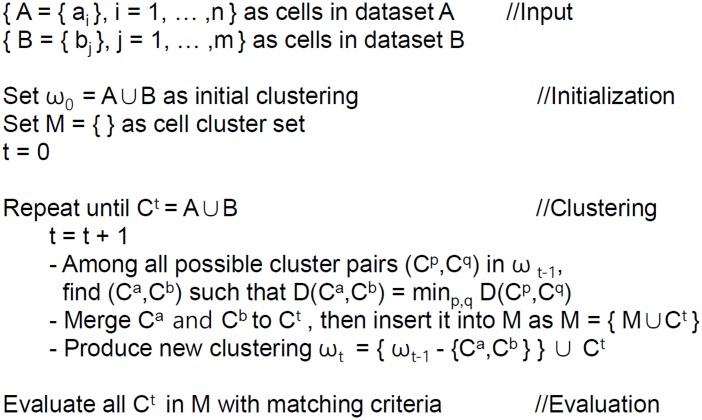
The pseudo-code of clustering method.